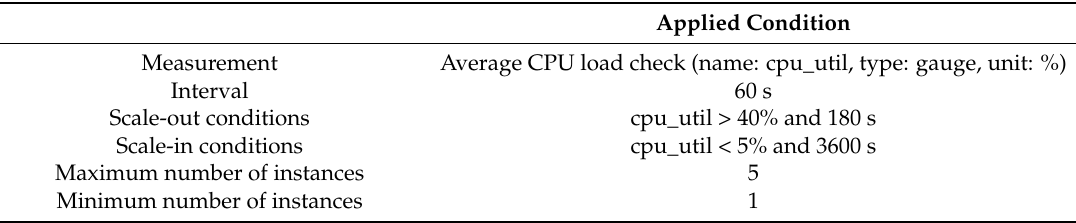
Figure 3. Example data for auto-scaling experiments and one case from OTB-based algorithms in a cloud computing environment: ( a ) tiled part of KOMPSAT 3 data image set (10 September 2014; 40 ° 25 ′ 52 ″ N, 3 ° 42 ′ 20 ″ W); ( b – d ) show the results of binary thresholding, MAF, and NDVI, respectively; ( e ) shows a tiled part of the KOMPSAT 3 image set for a cloudy scene (2 May 2015; 27 ° 41 ′ 54 ″ N, 85 ° 19 ′ 27 ″ E); and ( f ) shows the cloud detection result. Table 3. Virtual server rules for auto-scaling experiment.